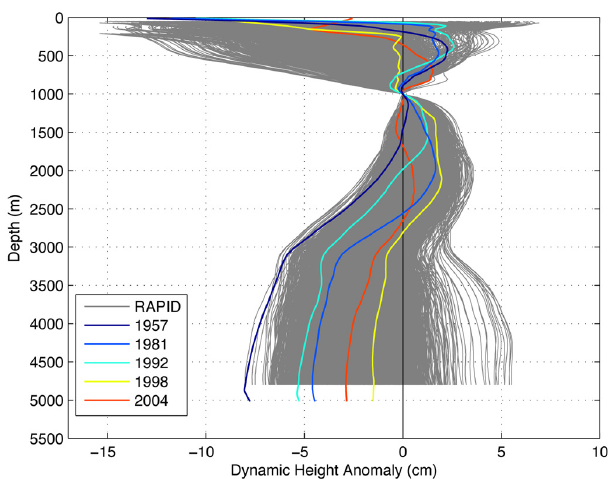
Fig. 15. Dynamic height anomaly profiles (cm) for the six hydro- graphic sections, with respect to the 2010 section (i.e., the dynamic height profile for the 2010 section is subtracted from all other pro- files), for profiles adjacent to the western boundary. Dynamic height anomaly profiles from 5 years of Rapid-WATCH western margin mooring data are also shown. A reference level of 1000m is as- sumed in the region of the DWBC, consistent with the calculation of transports described in Sect. 2.3. Each hydrographic dynamic height profile is constructed by merging together hydrographic stations ad- jacent to the western margin (e.g., if the western most station ex- tends from the surface to 200m depth, this is then merged with data deeper than 200m from the next station east; this appending pro- cess is continued until a single full depth hydrographic profile is obtained reaching from the surface to 5000m depth). For Rapid- WATCH data, WB2 data shallower than 4000m are merged with WB3 data deeper than 4000m (Sect.